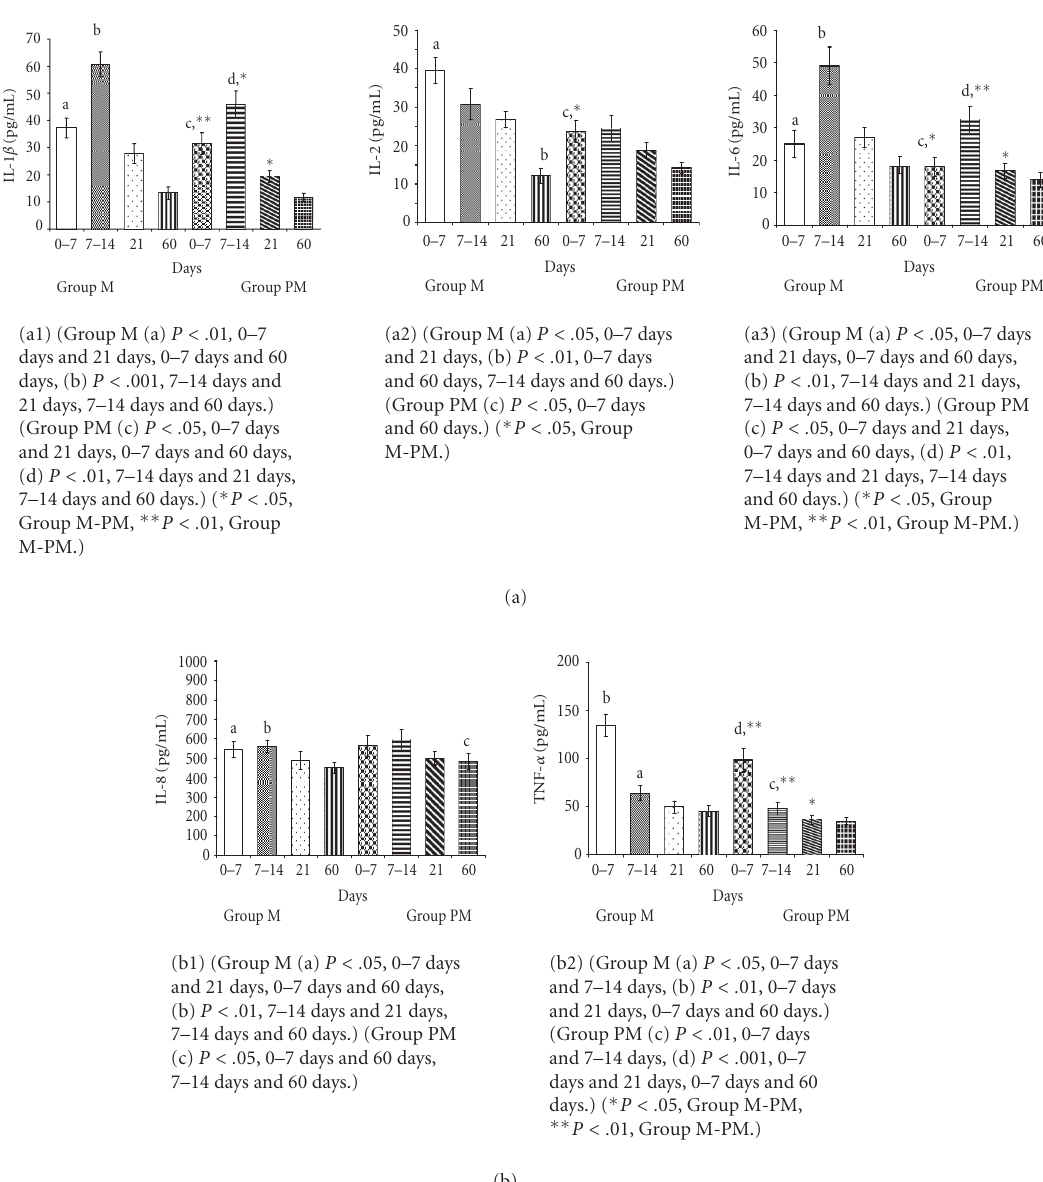
Figure 1. (a) Comparison of cytokine (IL-1 β , IL-2, IL-6) levels in milk from mothers of mature (group M) and premature (group MP) infants. (b) Comparison of cytokine (IL-8, TNF- α ) levels in milk from mothers of mature (group M) and premature (group PM)